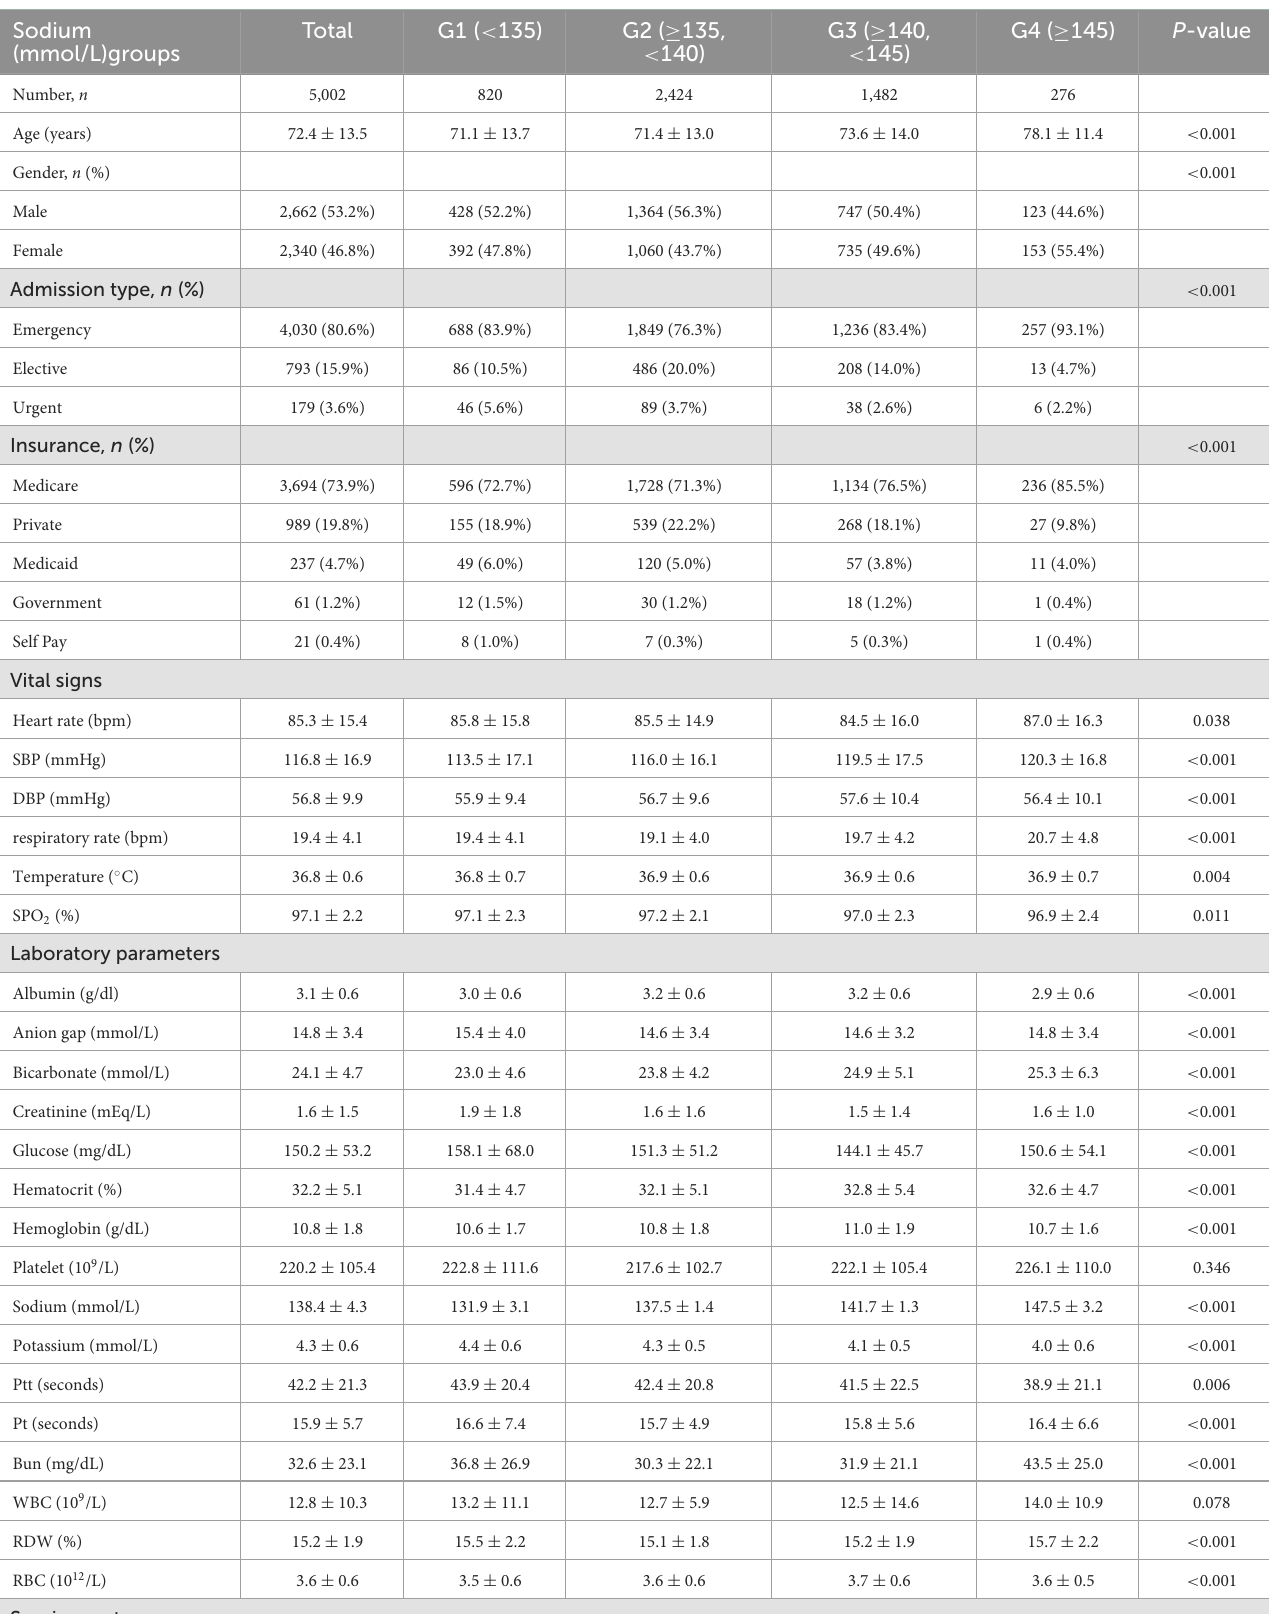
TABLE 1 Participant’s baseline characteristics ( N =